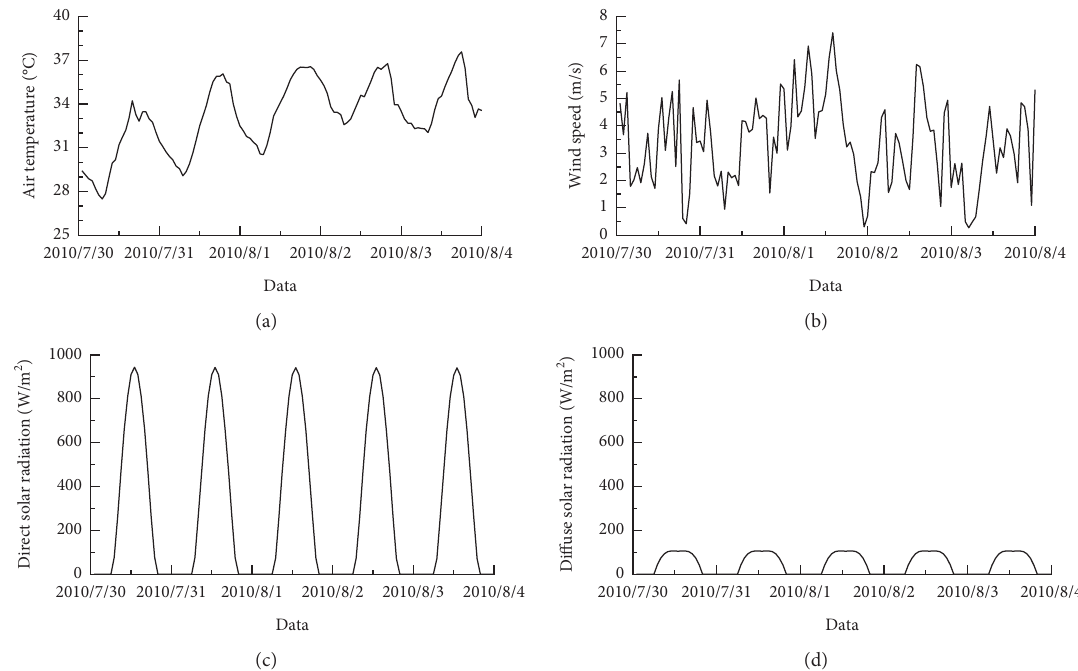
Figure 9: Hourly environmental records for the period from July 30 to August 3, 2010: (a) air temperature, (b) wind speed, (c) direct solar radiation, and (d) diffuse solar radiation. Table 1: Material properties.